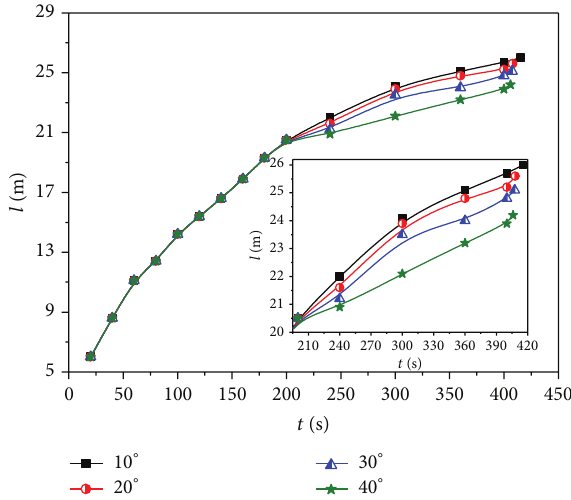
Figure 14: The gas mixture length varied with time at different inclination